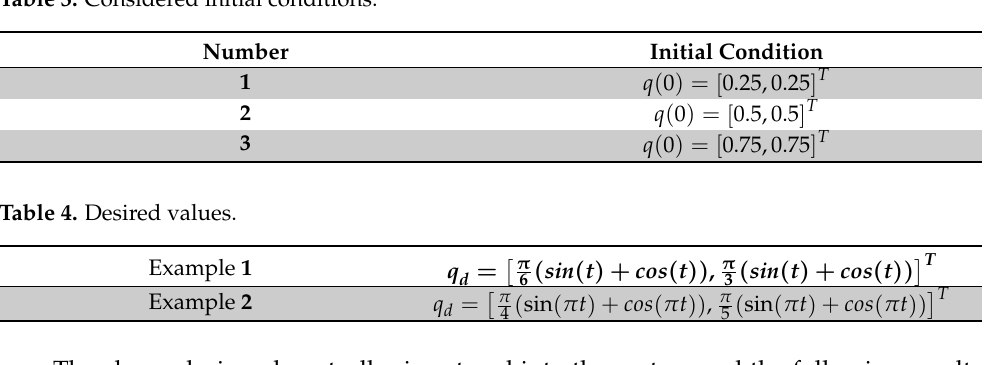
Table 3. Considered initial conditions.